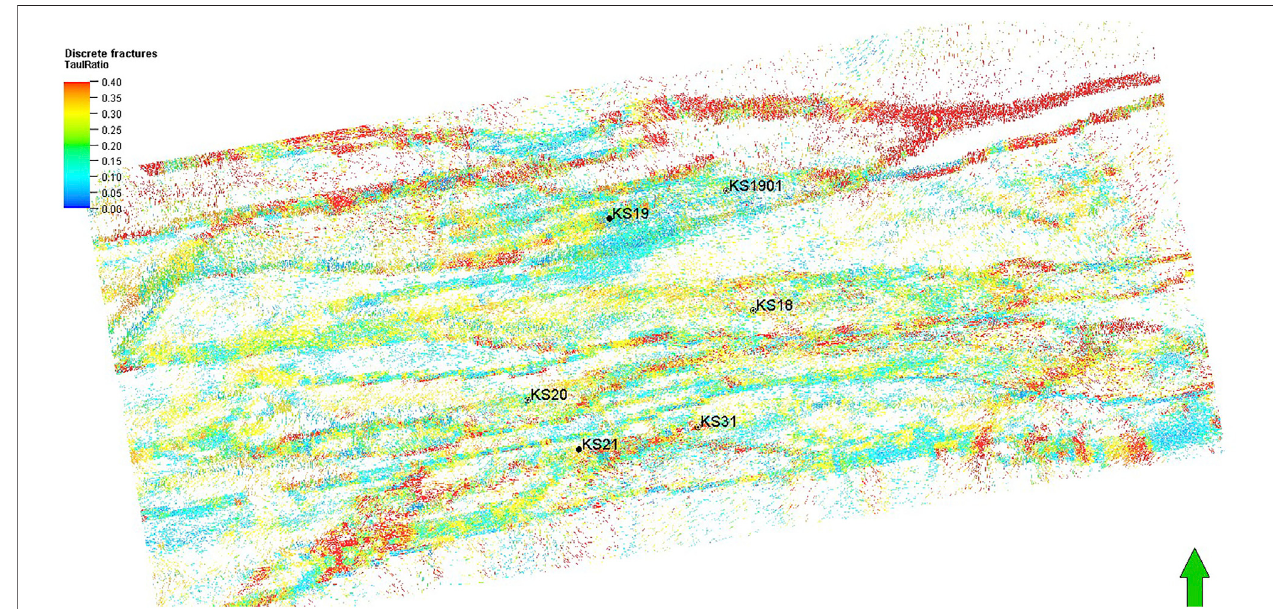
FIGURE 11 | Effectiveness prediction of natural fractures in keshen19-Keshen21